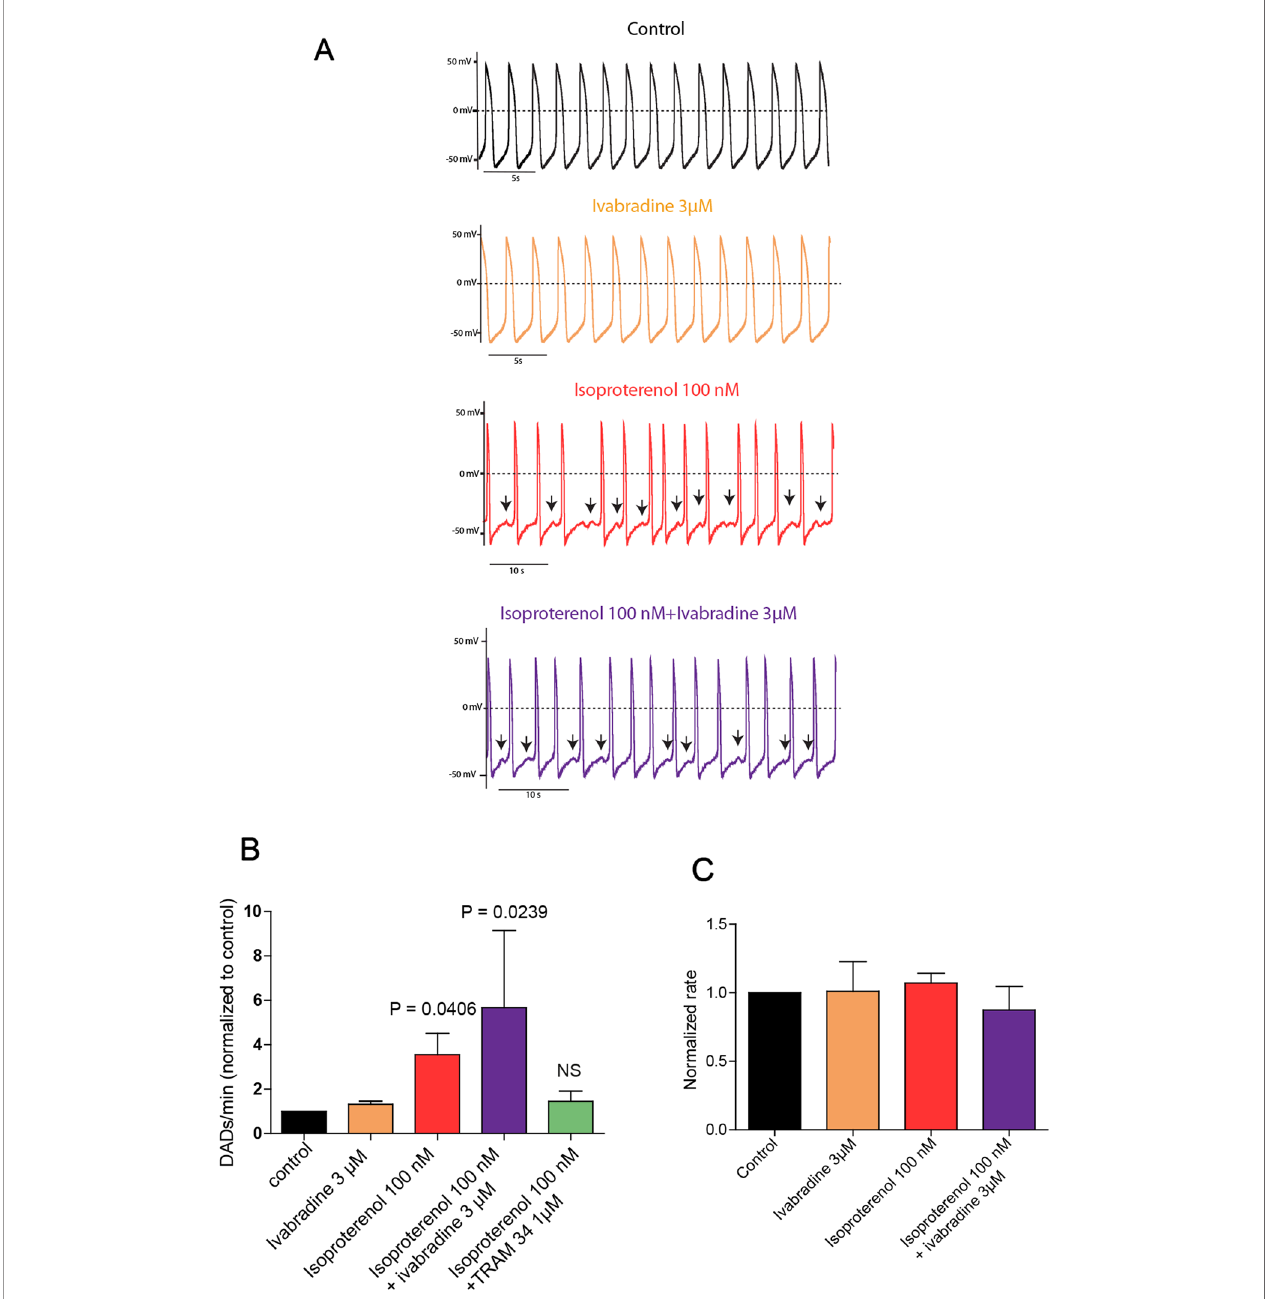
FIGURE 1 | Ivabradine does not prevent the occurrence of delayed-afterdepolarizations (DADs) in human induced pluripotent stem cells derived cardiomyocytes (hiPSC-CMs) derived from CPVT2 (CASQ2-D307H) patients. (A) Representative traces of spontaneous action potential (AP) recorded in CASQ2 D307H hiPSC-CMs are shown from the same cell in the absence of any drug (black trace, control), then in the presence of 3 m M ivabradine (orange trace), 100 nM of isoproterenol (red trace), and both isoproterenol + ivabradine (purple trace). (B) Data summary for each treatment of the numbers of DADs, which were normalized to those obtained in the same cell before the addition of any drug. Isoproterenol (100 nM) increased DADs by 3.56 ± 0.96-fold [n = 19, P = 0.0147, one-way ANOVA (F = 3.402; P = 0.0147); Dunnett ’ s multiple comparisons test, P = 0.0406]; ivabradine (3 µM) + isoproterenol (100 nM) increased DADs by 5.67 ± 3.47-fold, n = 4, one-way ANOVA (F = 3.402; P = 0.0147); Dunnett ’ s multiple comparisons test, P = 0.0239; TRAM-34 (1 µM) + isoproterenol (100 nM) increased DADs by only 1.45 ± 0.41 – fold, which is not signi fi cant (NS) compared to control; n = 15, one-way ANOVA (F = 3.402; P = 0.0147); Dunnett ’ s multiple comparisons test, P = 0.983. (C) Data summary of the normalized beating rates for each treatment. Beating rates were normalized those obtained in the same cell before the addition of any drug (control).The ANOVA test found no signi fi cant